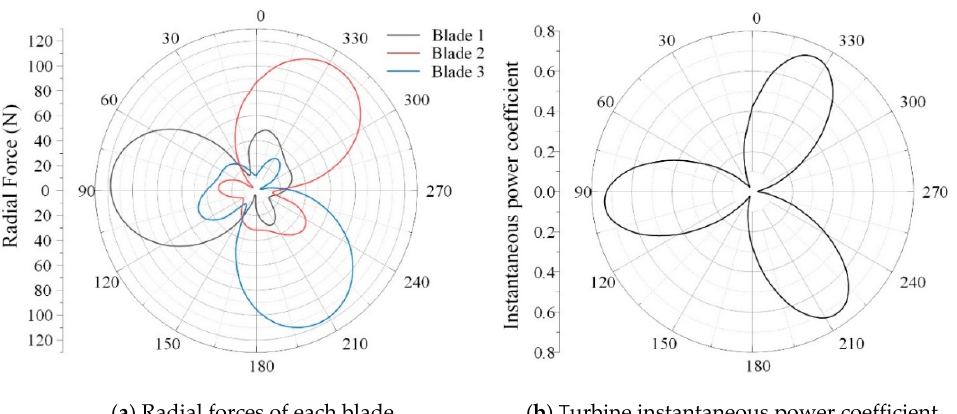
Figure 15. Radial forces and power coefficient. ( a ) Radial forces of each blade and ( b ) turbine instantaneous power coefficient at λ = 2.0.